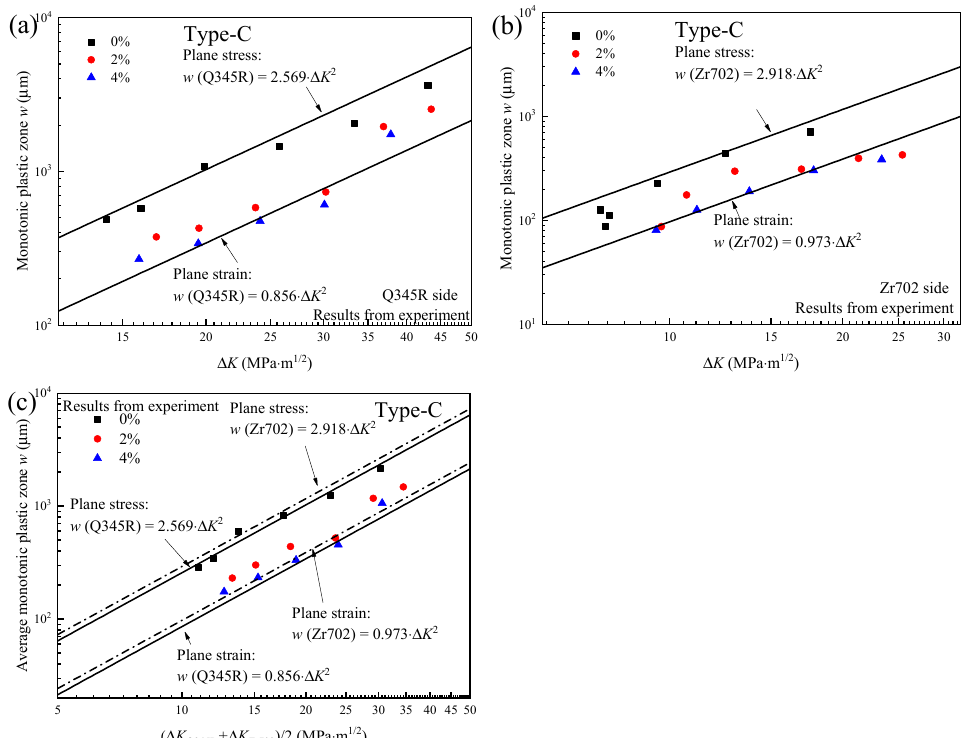
Figure 13. Effect of pre-strain on plastic zone for both sides and whole crack: ( a ) Q345R side, ( b ) Zr702 side, ( c ) whole crack.